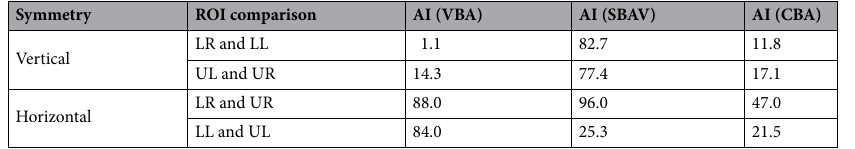
Probability map Analysis method Number of vertices MPO (%)